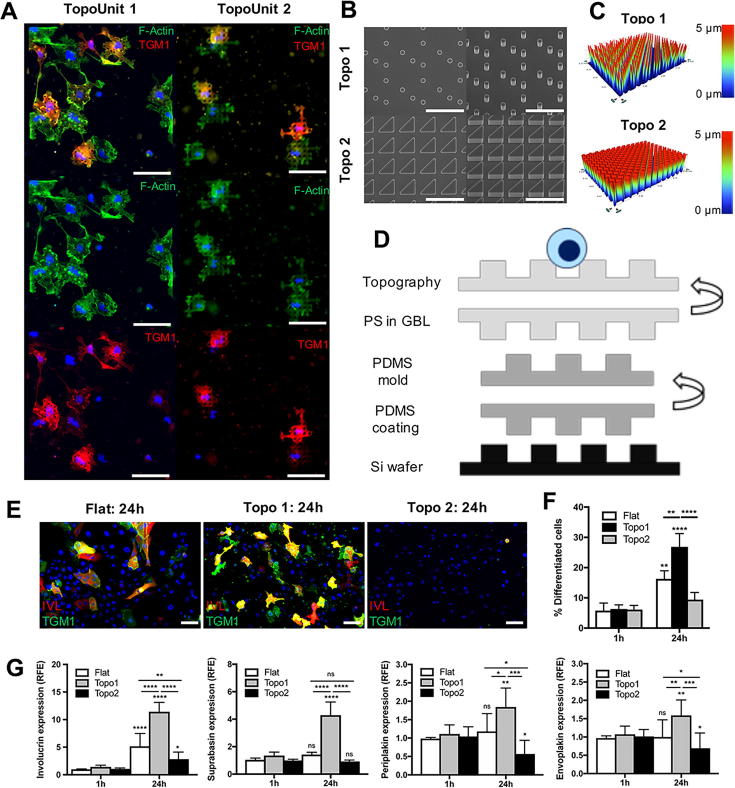
Validation of hits using fabricated polysterene topographies. A) Fluorescent microscopic images (20× objective) from TopoUnits that were chosen for further validation based on the analyses presented in Fig. 3. The first row represents composite images of all fluorescent channels; the second row an overlay of F-Actin (green) and DAPI staining (blue); and the last row an overlay of TGM1 (red) and DAPI staining. The first column represents the TopoUnit on which topography 1 was based. The second column represents the TopoUnit on which topography 2 was based. B) Scanning electron microscopy (SEM) images and C) height profiles of the fabricated topographies. In B) the first column represents top-view SEM images, while the second column represents images from a tilted (30°) view. D) Schematic overview of production of polystyrene (PS) topographies. Production starts with a silicon (Si) wafer, which is coated with polydimethylsiloxane (PDMS) to create a negative mould of the topographies after curing (>5h at 80 °C). The negative mould is then coated with PS that is dissolved in γ-butyrolactone (GBL). Upon evaporation of the solvent (4 h at 95 °C, followed by >12 h at 150 °C) this creates solid PS topographies that can be used for cell culture. E) Fluorescent microscopic images (20x) showing staining for TGM1 (green) and IVL (red) on flat and topography surfaces after 24 h of culture. Images represent overlays of DAPI (blue), TGM1 (green) and IVL (red). F) Quantification of the proportion of differentiated cells after 1 h versus 24 h of culture. G) Relative expression of the differentiation markers IVL, suprabasin, envoplakin and periplakin after 24 h of culture as determined by qRT-PCR. In F) differentiated cells are cells positive for TGM1. Scale bars represent 50 μm in A and E and 20 μm in B. Results in F and G are from 3 independent experiments. Results in A and E are representative images from five and three independent experiments, respectively. ns: not significant, *p < 0.05, **p < 0.01, ***p < 0.001, ****p < 0.0001 as determined by two-way ANOVA test (including Tukey correction for multiple comparisons). TGM1: transglutaminase-1, IVL: involucrin. RFE: relative fold expression. Topo1: topography 1, Topo2: topography 2. Si: silicon, PS: polystyrene, GBL: γ-butyrolactone, PDMS: polydimethylsiloxane.